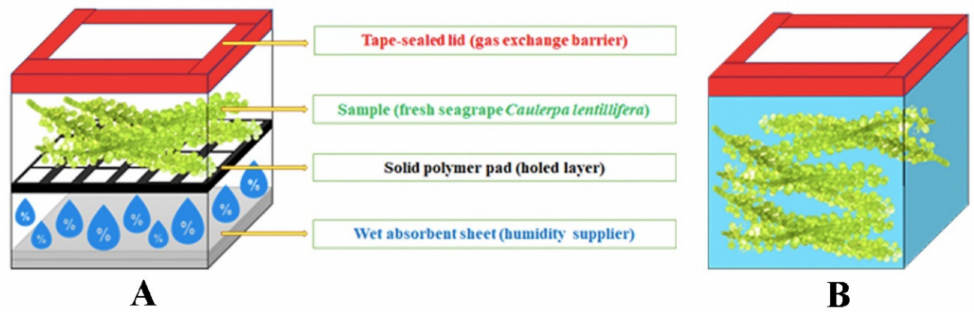
Figure 1. Packaging prototype for the oxidative stress environment ( A ) storage without seawater ( B ) storage within